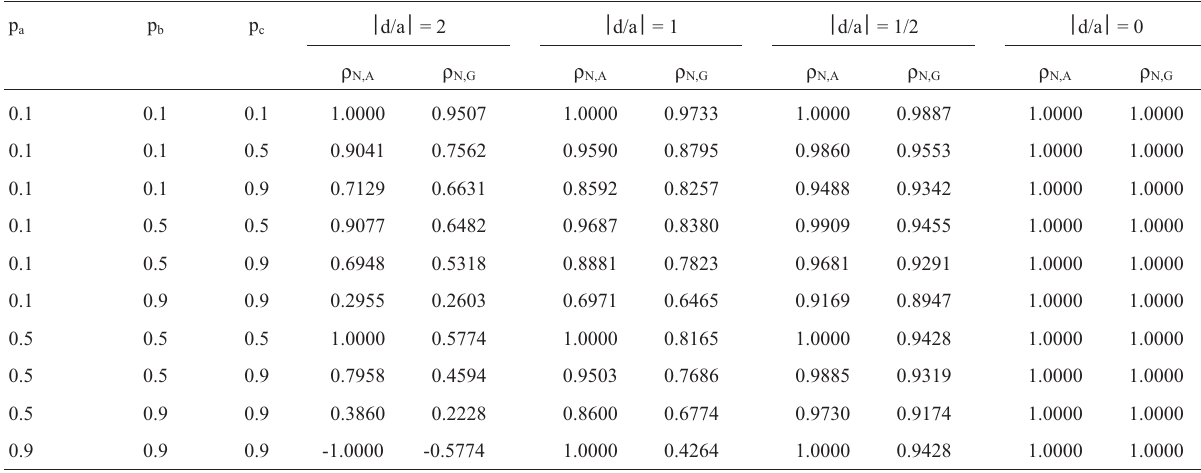
Table 1 - Correlations between the number of genes that increase the trait expression (N) and the additive genetic value (A) and the genotypic value (G; assumingabsenceofepistasis),consideringthreegenes,differentpopulations(pisthefrequencyofthedominantgene)andfourdegreesofdominance. p a p b p